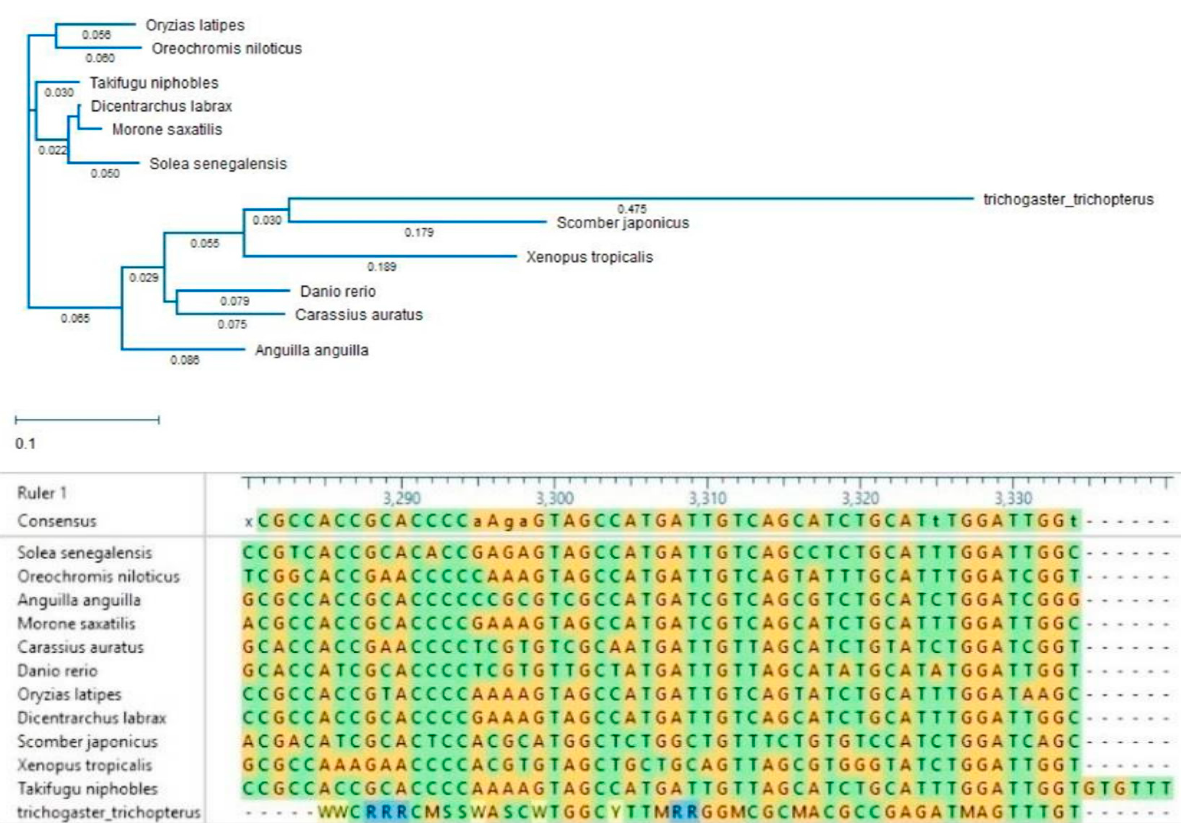
Figure 12. Phylogenetic tree and DNA sequences showing the relationships between vertebrate Kiss1r cDNA sequences. The tree was generated using MAFFT alignment in DNASTAR MegAlign PRO [30]. T. trichopterus sequence was obtained from [29]. All other sequences were obtained from NCBI GenBank according to the accession numbers provided in [30]. The units of branch length represent nucleotide substitutions per site.